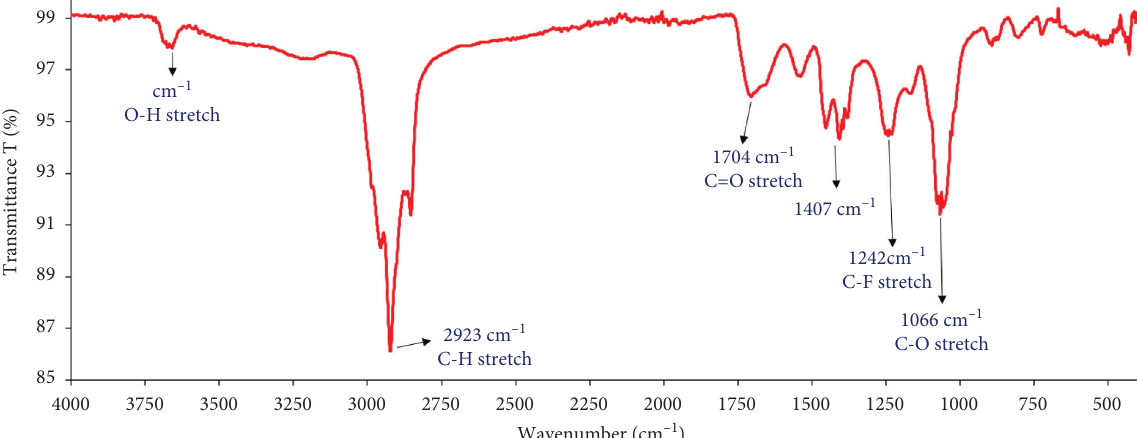
Figure 4: Absorption peaks in FT-IR spectra of the coated woven fabric (fluorocarbon resin: 15%, acrylic paste: 150gm − 2 , and reticulation time: 6min).